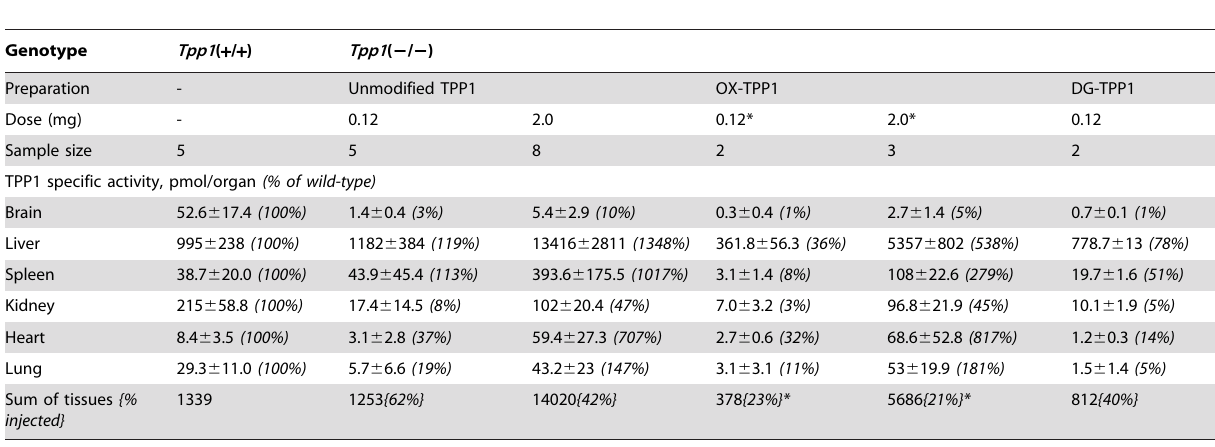
Table 1. Biodistribution of TPP1 preparations 24 hours following IV administration.